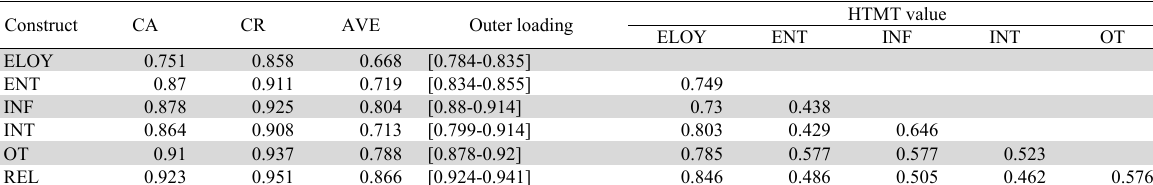
Result of Measurement model Construct